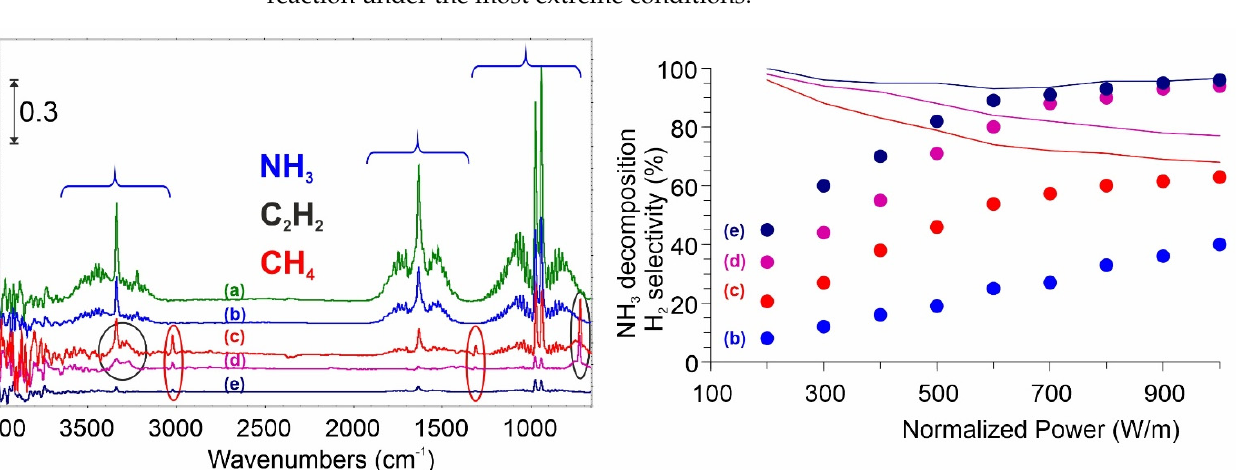
Figure 3. Raman spectra and SEM pictures of tested materials before (red) and after (blue) 30 min reaction under NH 3 NTP. While ammonia is adsorbed on carbonaceous material, some characteristic surface species are formed. As a result of NH 3 adsorption (Figure 4, red spectrum), broad, mutu- ally overlapped IR bands in the region of OH and NH stretching vibrations are formed at 3456, 3381, 3207, 3031 1/cm. The shape (wideness) of these bands and the presence of a signal at 2800 1/cm indicate the formation of hydrogen bonds. Their origin may be both: (i) hydrogen bonds between adsorbed NH 3 molecules and oxygen-functional groups of C ox , or (ii) adsorbate–adsorbate-type interactions between physically adsorbed NH 3 and previously chemisorbed molecules. The spectral changes in the region of C=O stretching vibrations are caused by ammo- nia chemisorption on the oxidized carbon surface. The disappearance of band doublet at 1841 and 1753 1/cm is due to the reaction between NH 3 and surface anhydrides. One of